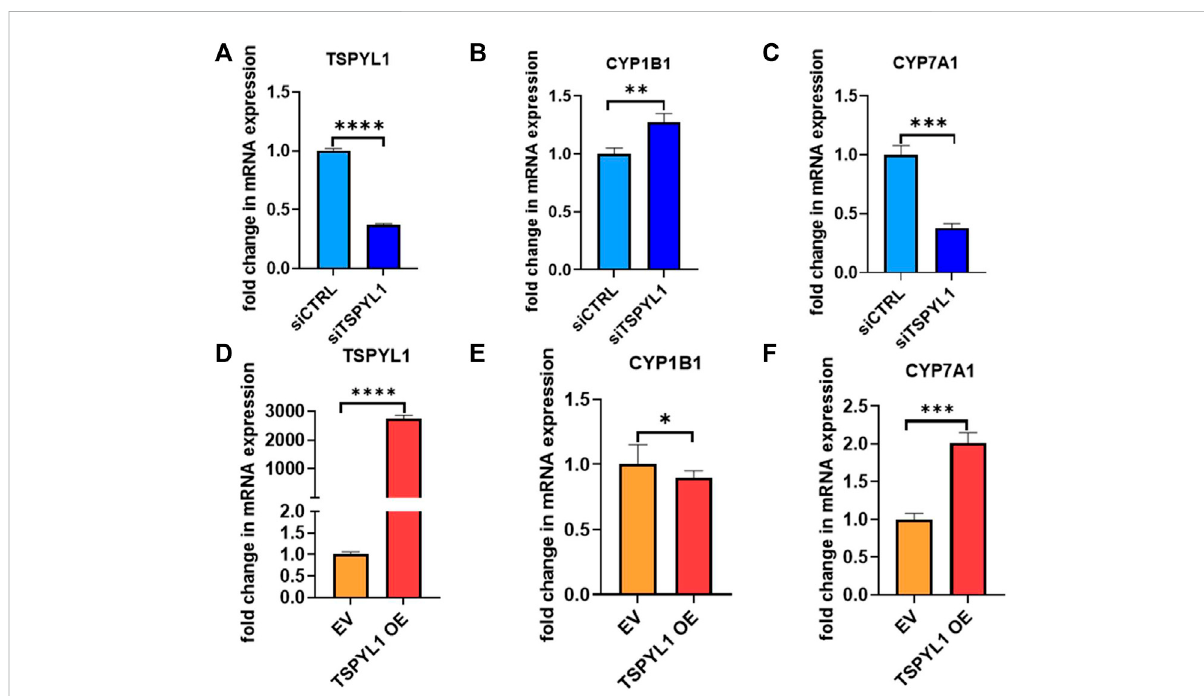
FIGURE 3 TSPYL1regulates CYP1B1 and CYP7A1 expressioninHepaRGcells. (A) HepaRGcellswithorwithoutTSPYL1depletionbysiRNAweretransfected as indicated. CYP1B1 (B) and CYP7A1 (C) expression were tested by qRT-PCR. (D) HepaRG cells with or without TSPYL1 overexpression were transfectedasindicated. CYP1B1 (E) and CYP7A1 (F) expressionweretestedbyqRT-PCR.Gene-speci fi cdatawerenormalizedtoGAPDHexpression. Errorbarsindicatedstandarddeviationsamong3technicalreplicatesperexperiment.Dataarerepresentedasmean±SD.(* p < 0.05,** p < 0.01, *** p < 0.001, **** p <